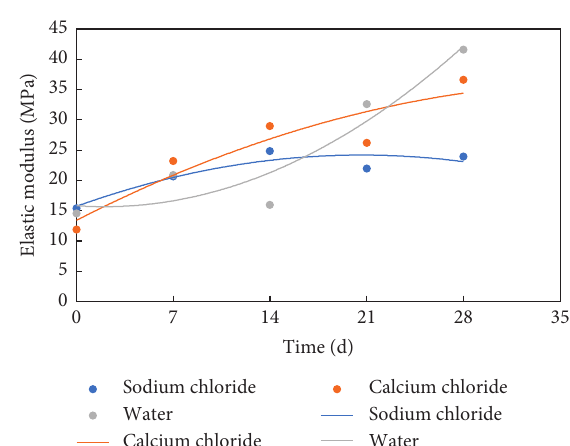
Figure 17: Change of elastic modulus of the cylindrical specimen with HWC